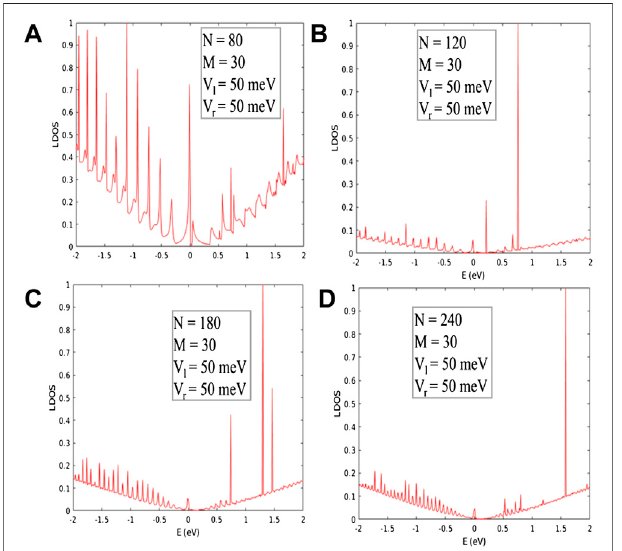
FIGURE 6 | LDOS for asymmetric potential well with (A) N = 80, (B) N = 120, (C) N = 180, and (D) N =